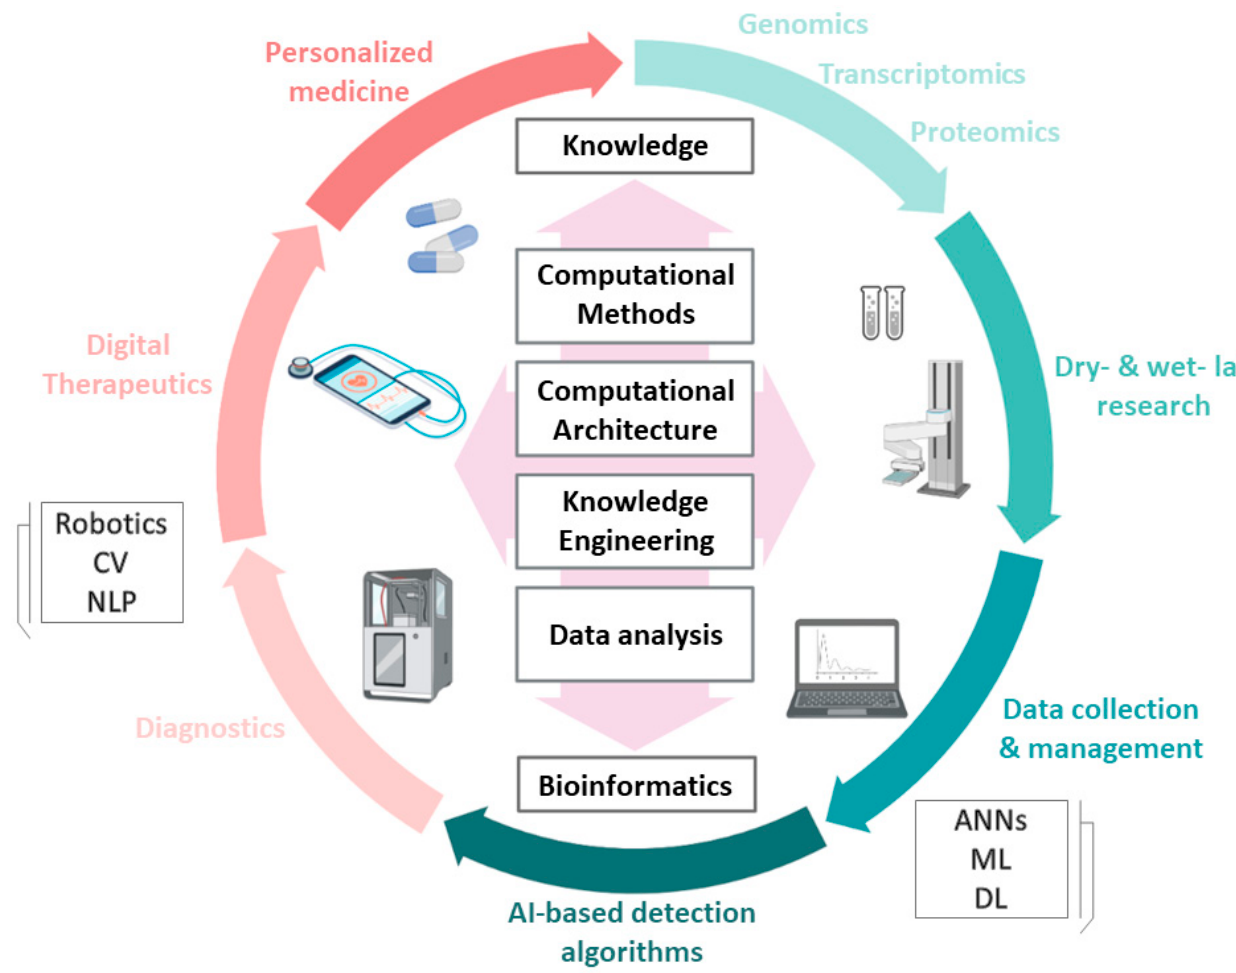
Figure 2. Illustration depicting the involvement of AI ‐ based tools in the different levels of modern biomedicine.